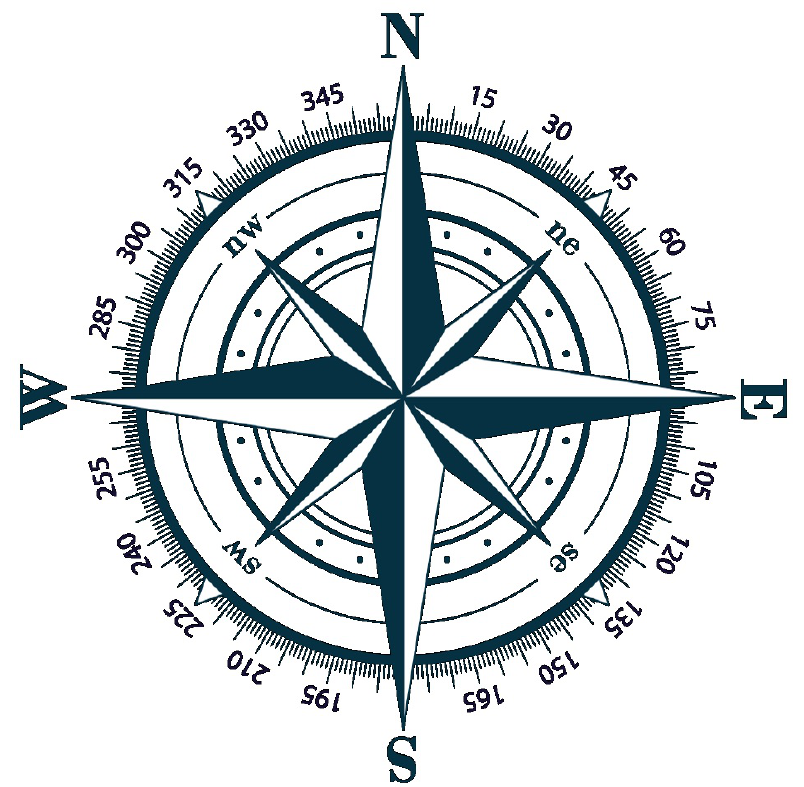
Figure 13. The main compass axes featured by the line-drawing strategies on a continuum of equivalent